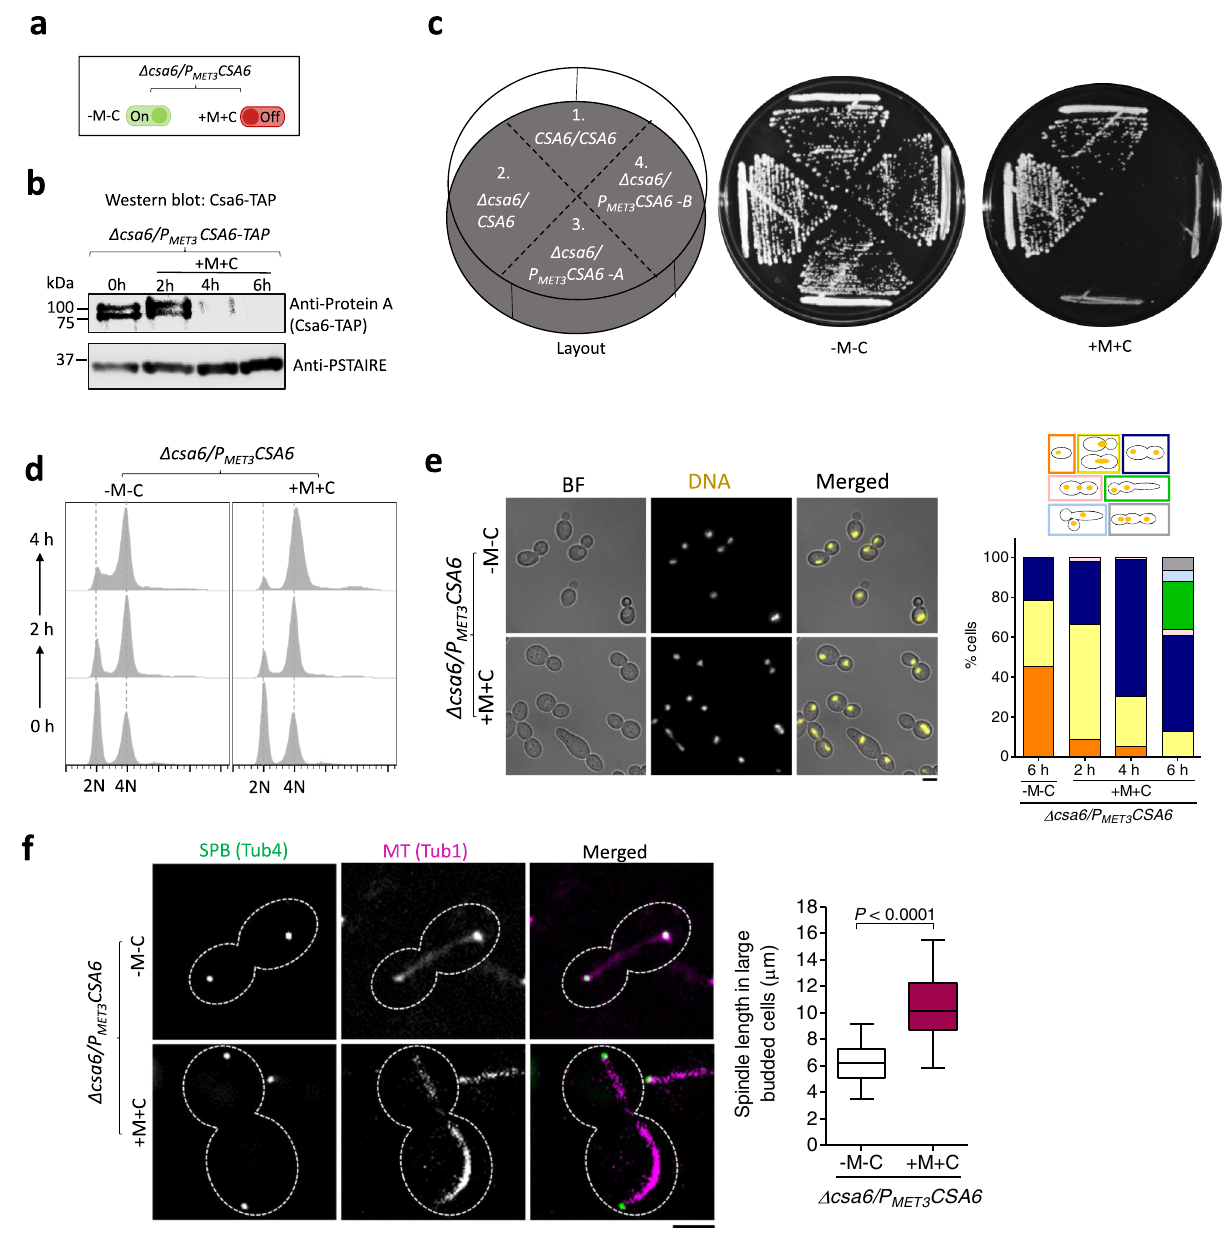
Fig. 5 Csa6 depletion causes late anaphase/telophase arrest with a hyper-extended mitotic spindle in C. albicans . a The MET3 promoter system for depleting cellular levels of Csa6. The MET3 promoter can be conditionally repressed in presence of methionine (Met/M) and cysteine (Cys/C). b Western blot analysis using anti-Protein A antibodies revealed time-dependent depletion of Csa6-TAP in CSA6 PSD strain (CaPJ212), grown under repressive conditions (YPDU + 5 mM Met and 5 mM Cys) for indicated time interval; N = 2. c Csa6 is essential for viability in C. albicans . Strains with indicated genotypes, (1) SN148, (2) CaPJ209, (3 and 4) CaPJ210 (two transformants) were streaked on agar plates with permissive (YPDU-Met-Cys) or repressive (YPDU + 5 mM Met and 5 mM Cys) media and incubated at 30 °C for two days. d Cell cycle analysis of CaPJ210 ( CSA6 PSD ) by fl ow cytometry under permissive (YPDU-Met-Cys) and repressive conditions (YPDU + 5 mM Met and 5 mM Cys) at the indicated time intervals; N = 3. e Left , microscopic images of Hoechst stained CaPJ210 ( CSA6 PSD ) cells grown under permissive (YPDU-Met-Cys) or repressive (YPDU + 5 mM Met and 5 mM Cys) conditions for 6 h. BF bright- fi eld. Scale bar, 5 µ m. Right , quantitation of different cell types at the indicated time-points; n ≥ 100 cells. f Left , micrograph showing Tub4-GFP and Tub1-mCherry (representing mitotic spindle) in the large-budded cells of CaPJ211 ( CSA6 PSD ) after 6 h of growth under permissive (YPDU-Met-Cys) or repressive (YPDU + 5 mM Met and 5 mM Cys) conditions. Scale bar, 3 µ m . Right , quantitation of the distance between the two SPBs, along the length of the MT (representing spindle length), in large-budded cells of CaPJ211 ( CSA6 PSD ) under permissive ( n = 32) or repressive ( n = 52) conditions. Box plots include the median line, the box denotes the interquartile range (IQR), whiskers extend down to the minimum value and up to the maximum value. Paired t -test, one-tailed, P -value shows a signi fi cant difference ( P < 0.0001). Source data are provided as a Source Data fi le.